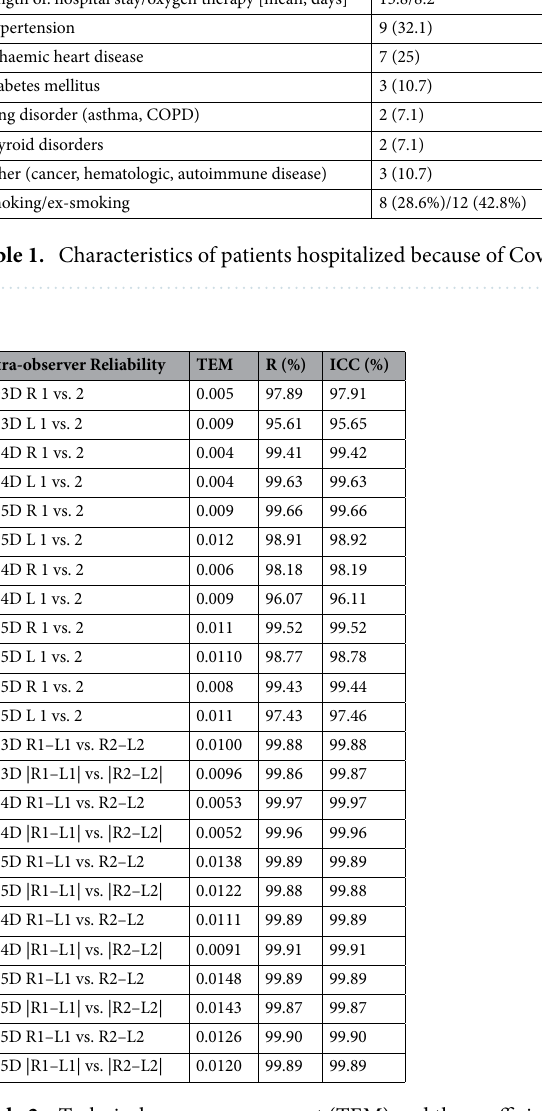
Table 2. Technical error measurement (TEM) and the coefficient of reliability for raw measurements (R) for ratios and for R–L and |R–L| of six ratios for observer